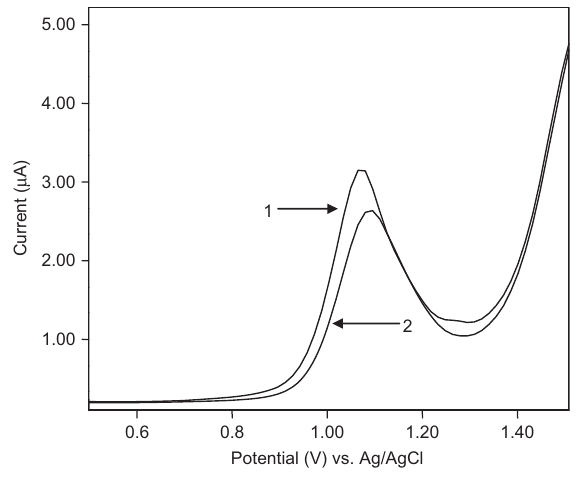
Figure 11 Curve (1) differential pulse voltammogram (DPV) of 1.0 × 10 -4 m gatifl oxacin at bare multi-walled carbon nanotube paste electrode (MWCNTPE) in 0.2 m acetate buffer (pH 5.0 ± 0.01), curve (2) DPV of 1.0 × 10 -4 m gatifl oxacin at DNA modifi ed MWCNTPE, pulse amplitude 50 mV, scan rate 50 mVs -1 , current range 10 μ A.